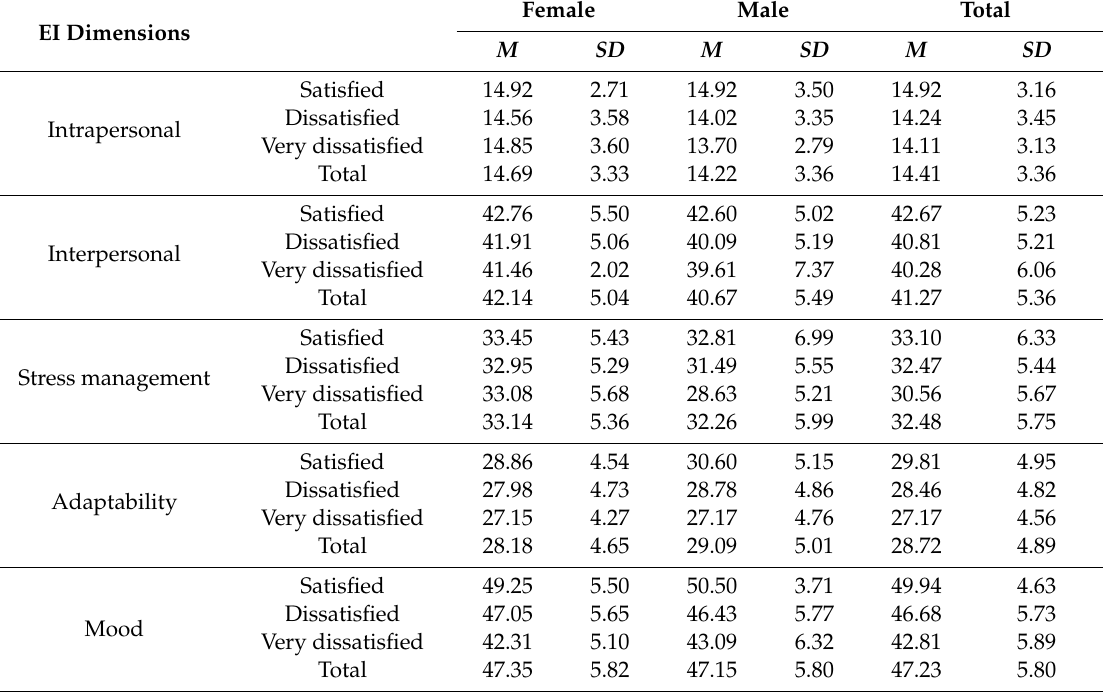
Table 3. Means and Standard Deviation of Emotional Intelligence Dimensions according to Body Image Satisfaction and